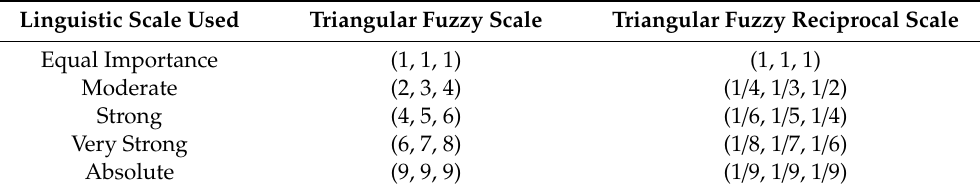
Table 1. Linguistic Scale of Relative